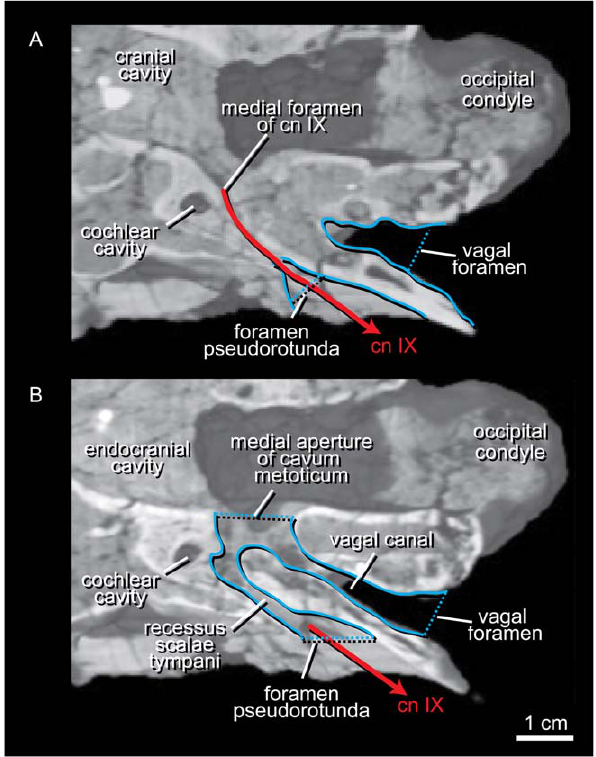
Figure 5. Two horizontal slices through the left cavum metoticum of Alioramusaltai (IGM 100/1844). The slices sample the upper (A) and middle (B) regions of this space. The glossopharyn- geal nerve (cn XI) enters the recessus scalae tympani through a foramen that is independent of the medial aperture of the cavum metoticum. Rostral is to the left.